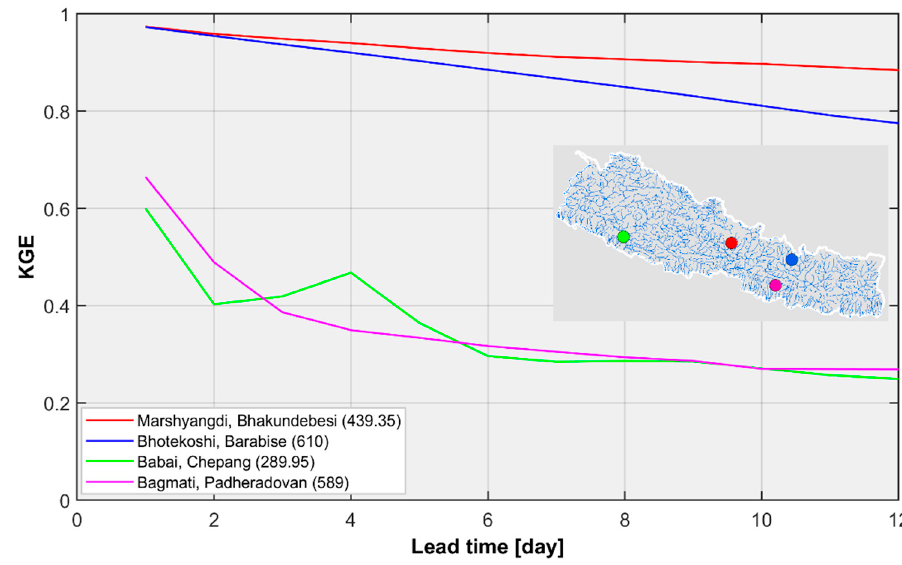
Figure 7. Evolution of Kling-Gupta e ffi ciency (KGE) metric with lead time. The lines in the top (red and blue) represent snow-fed river basins while the lines in the bottom (green and magenta) represent intermittent river basins. Note that all four river basins are of a similar size of ~2500 km 2 .